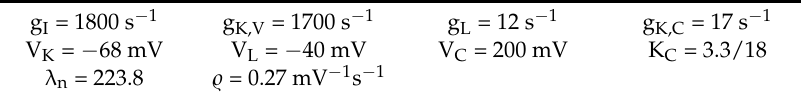
Table 1. Values of Chay neuron model